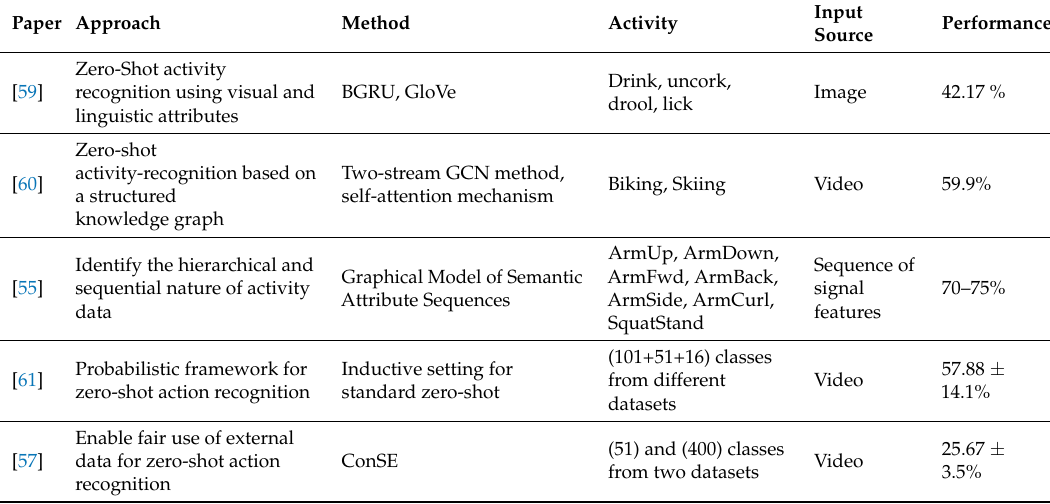
Table 3. Overview of activity recognition-based zero-shot learning. BGRU: Bidirectional Gated Recurrent Unit; GloVe: Global Vectors; ConSE: Convex Combination of Semantic